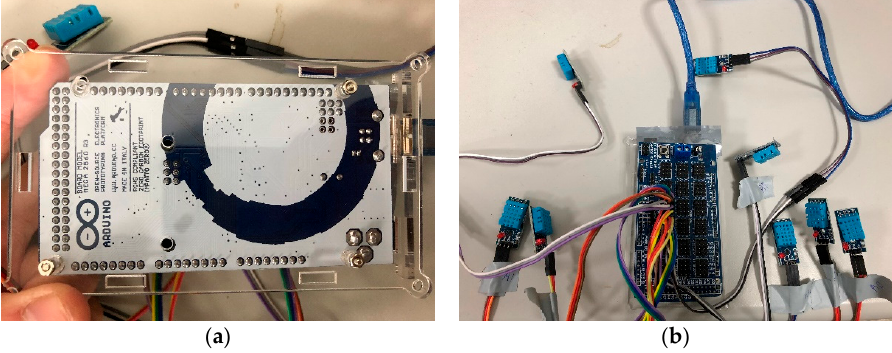
Figure 6. ( a ) Arduino Mega 2560 R3; ( b ) Arduino connection to DHT-11 temperature and humidity sensor.